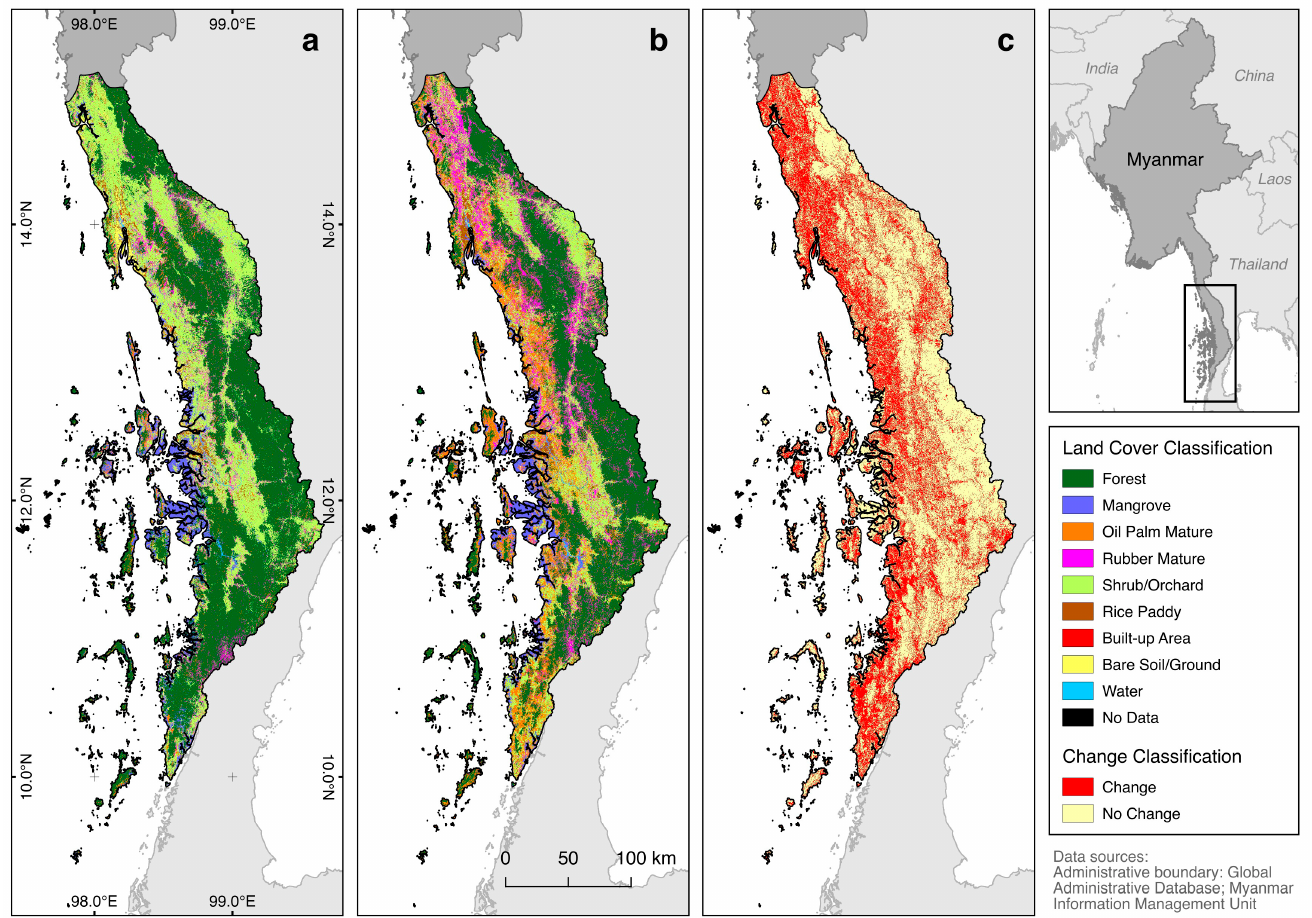
Figure 3. Land cover maps in ( a ) 1995 and ( b ) 2015, and ( c ) areas of land cover change within the 20-year period in Tanintharyi Region, Myanmar.